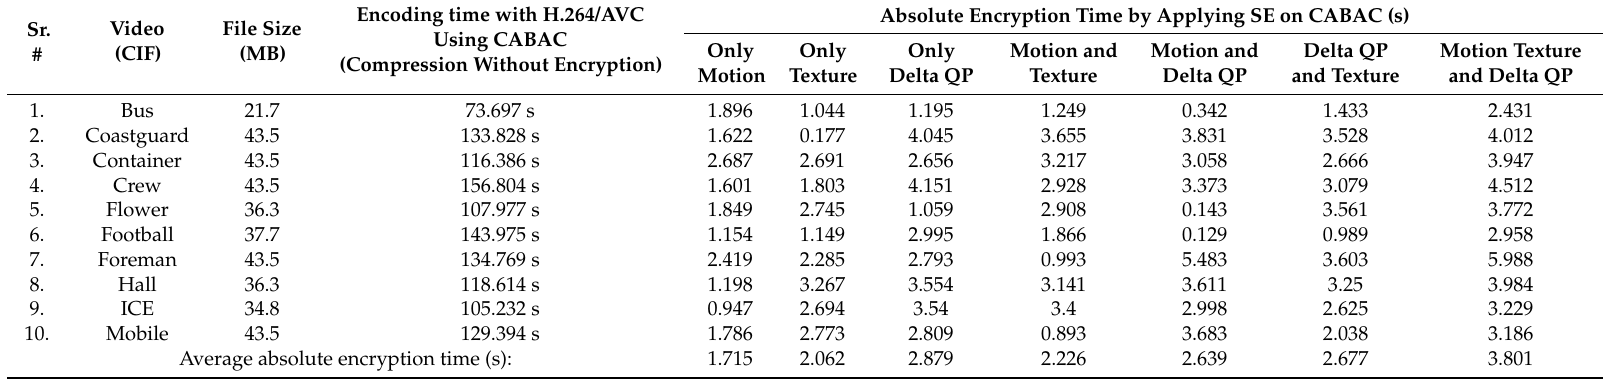
Table 5. Absolute encryption time (s) with H.264/AVC CABAC entropy coding on selected parameters (motion, texture, delta QP and their combination) with EXPer. Sr.